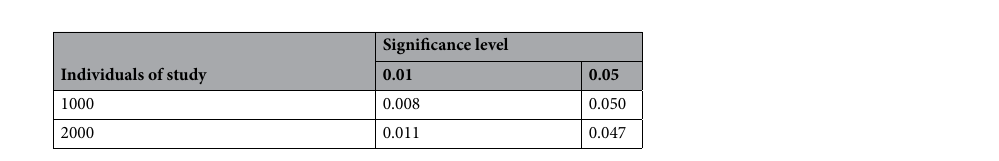
Table 4. The values of type I error rates at different scenarios for the test of SNP and SNP-environment joint effects with 40% overlapping data.